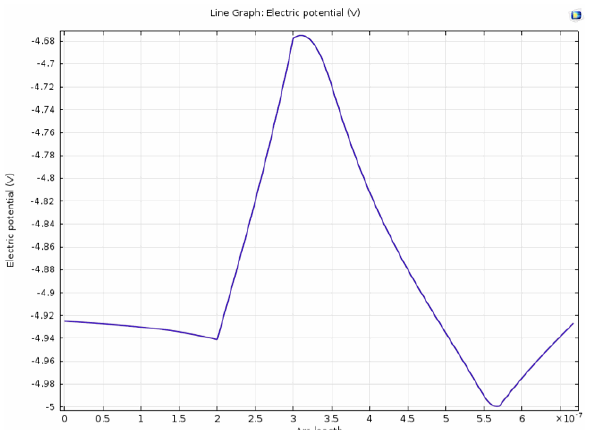
Figure 3. Electric potential generated in a-Si solar cell before adding passivation.